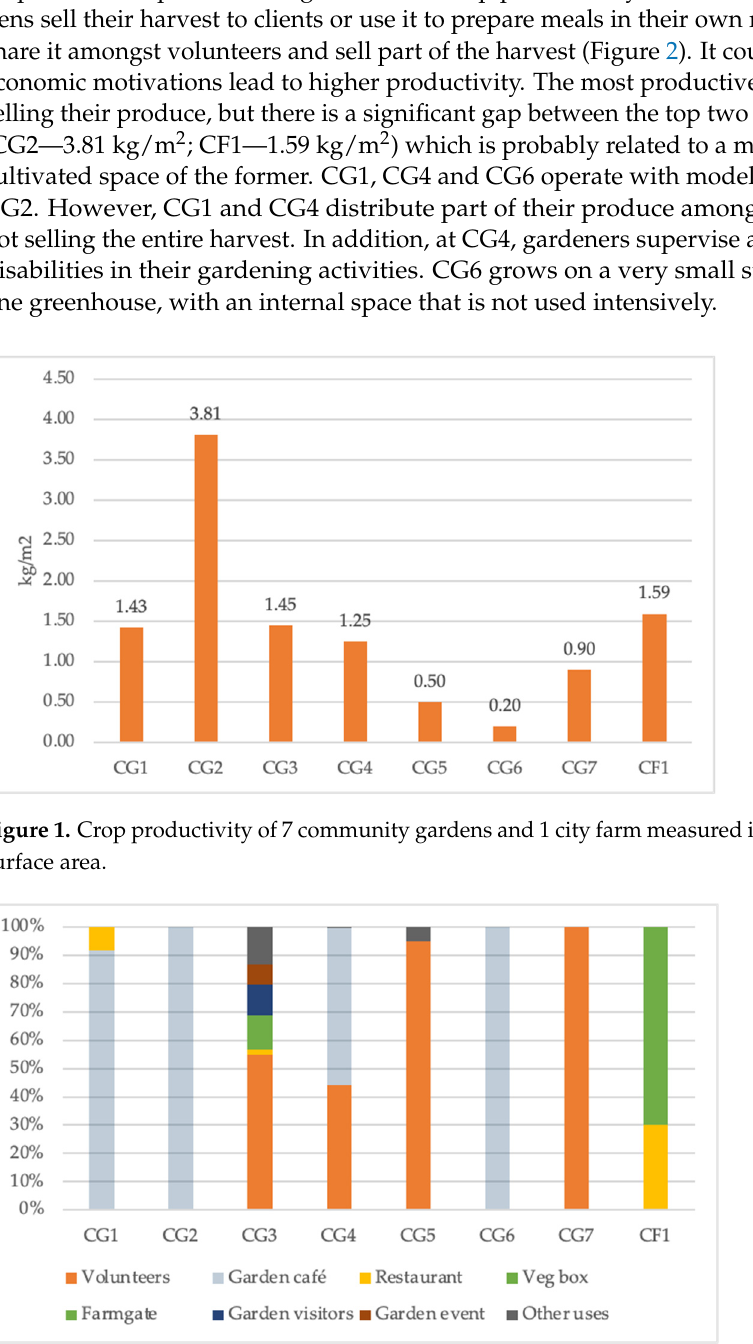
Figure 2. Destination of food for each garden.